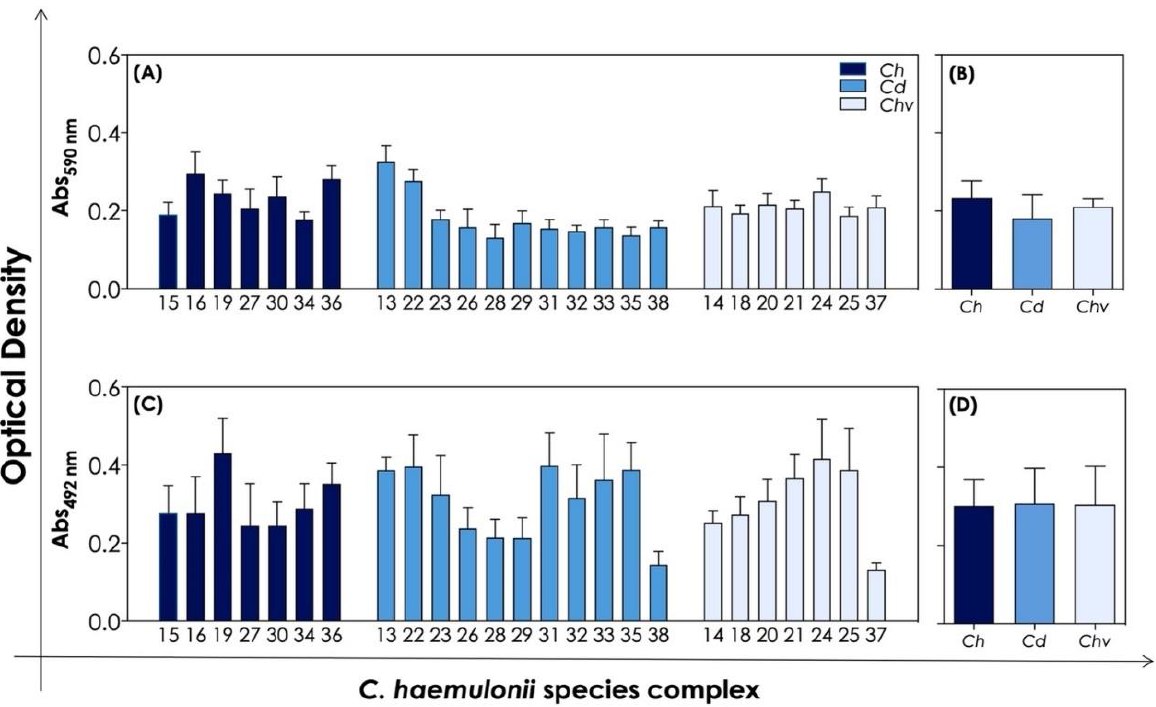
Figure 2. Biofilm formation by C. haemulonii species complex on a polystyrene surface. Biofilms were formed for 48 h at 37 ◦ C and then processed to detect the fungal biomass (590 nm) and cell viability (492 nm). The results are expressed as absorbance (ABS) values per clinical isolate studied ( A , C ) and mean per fungal species ( B , D ). The results represent means ± standard deviation of three independent experiments. The numbers on the X -axis of the graph represent each of the 25 isolates of the C. haemulonii complex used, in which Ch means C. haemulonii , Cd means C. duobushaemulonii and Chv means C. haemulonii var. vulnera .